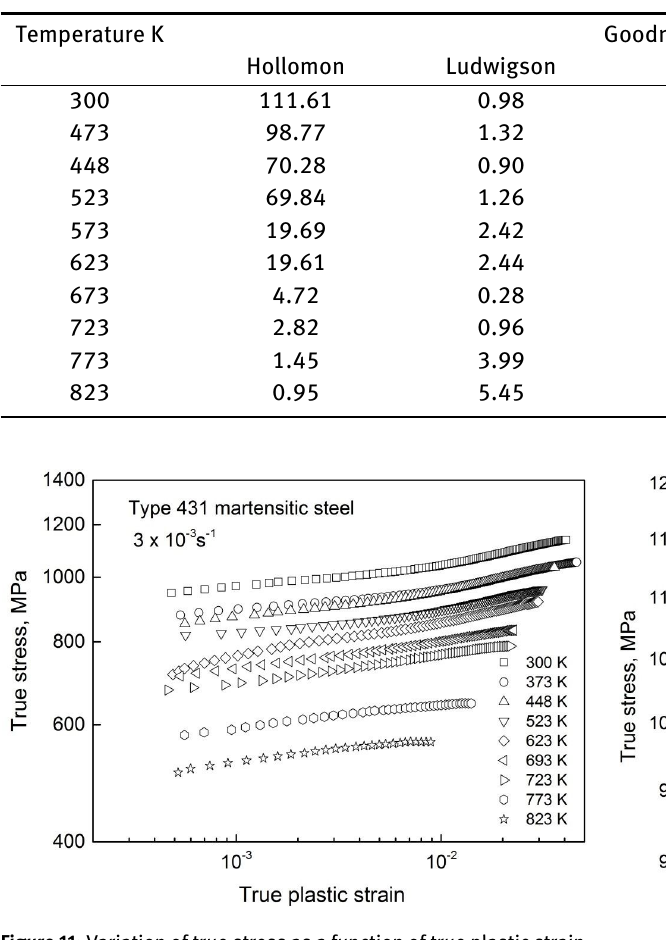
Figure 12: Applicability of various flow relationships namely, Hol- lomon, Ludwigson, Swift, Ludvik and Voce to describe the flow behaviour of AISI 431 steel at 300